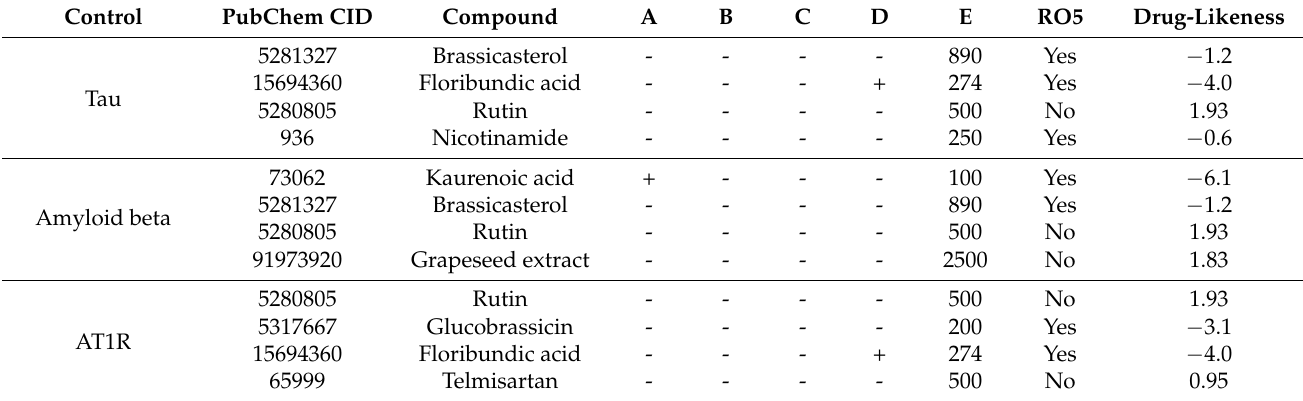
Table 1. Values of binding affinity [kcal/mol] of control ligand molecules relative to target peptides obtained during docking stage. pounds